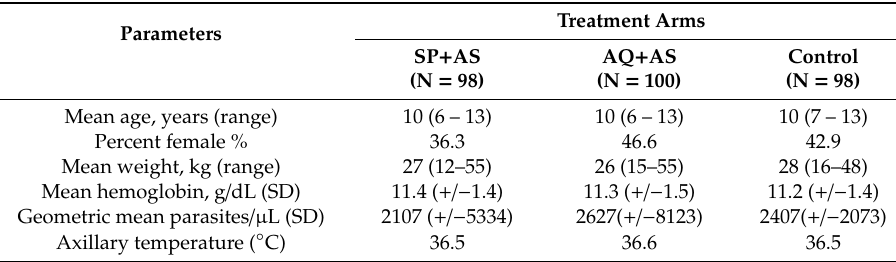
Table 1. Baseline Characteristics.